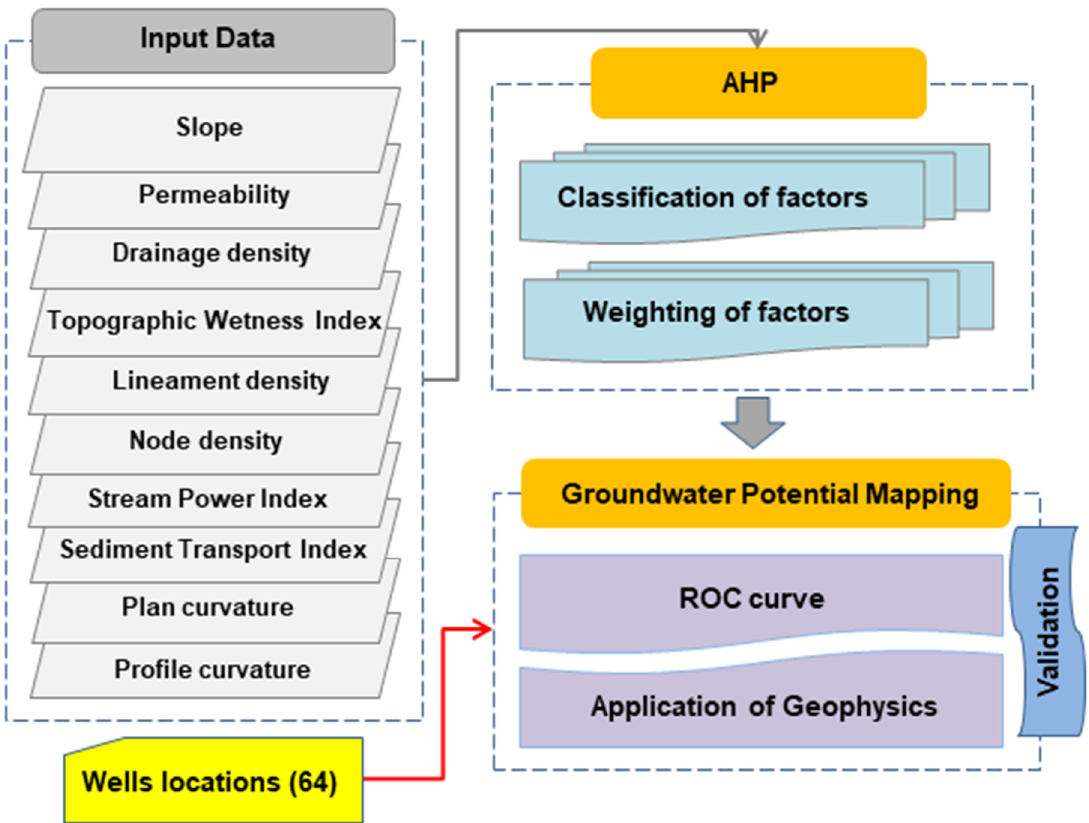
Figure 4. Flowchart of the methodology used in the Tata basin for the implementation of future wells.